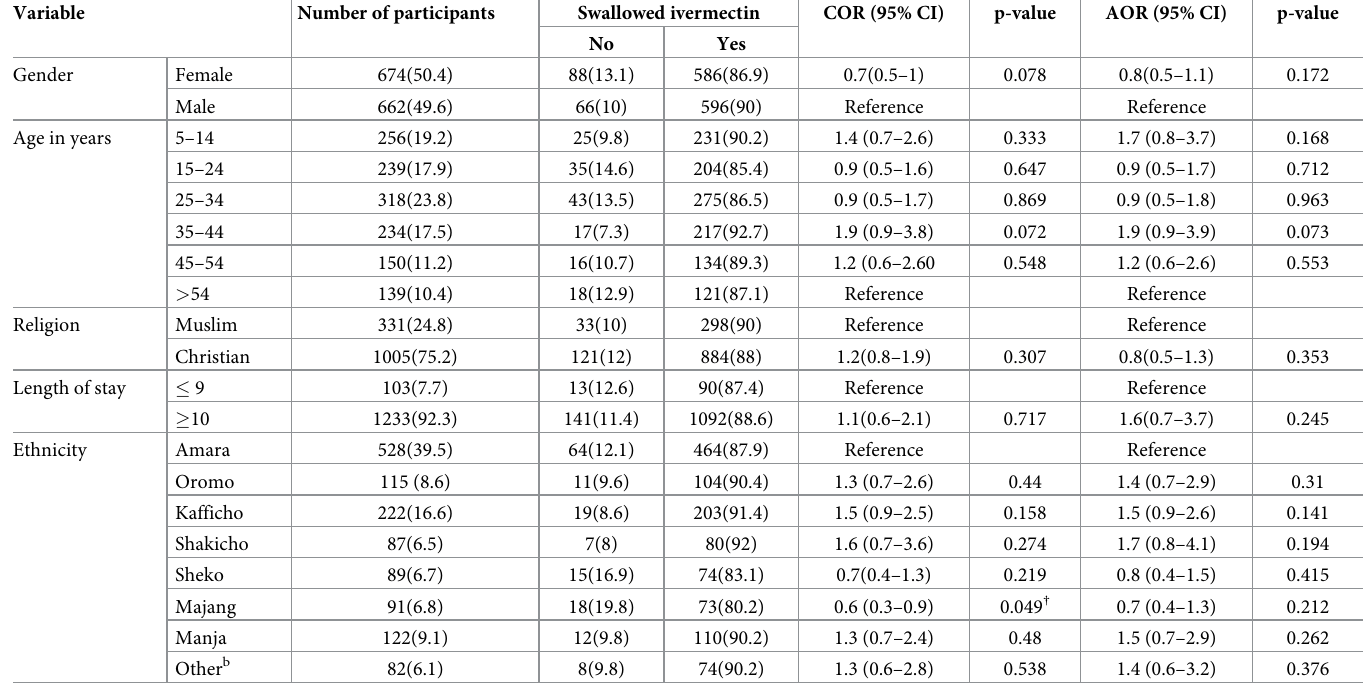
Table 4. Results of the regression analysis in the MDA coverage in Yeki